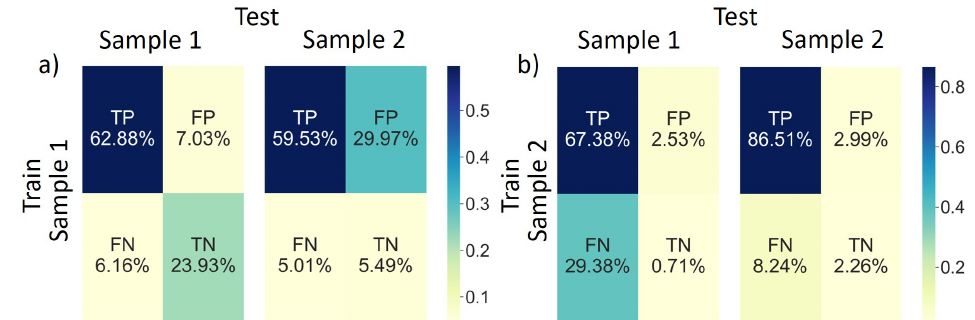
Figure 16. Confusion matrix training on ( a ) sample 1 and ( b ) sample